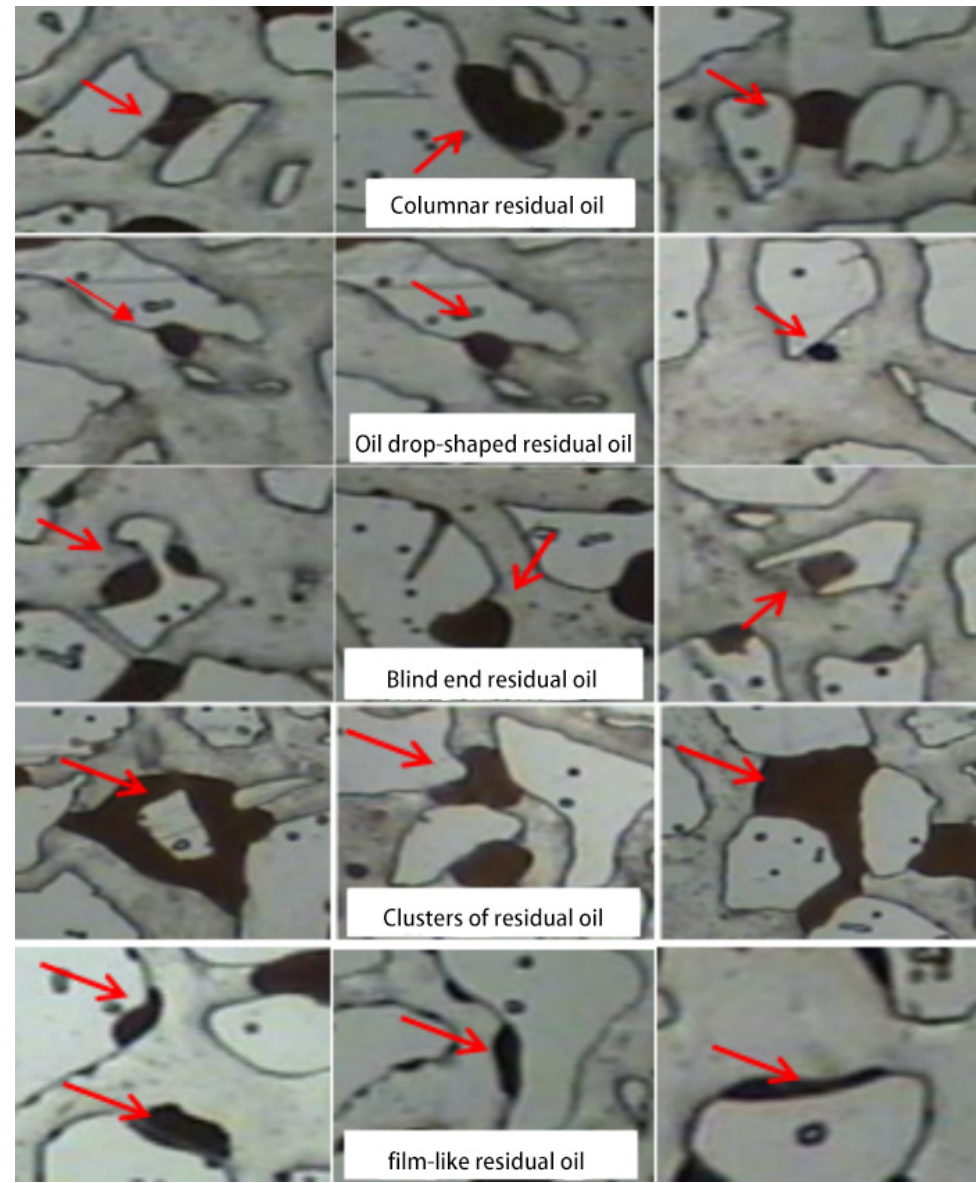
Figure 8. The different types of remaining oil.